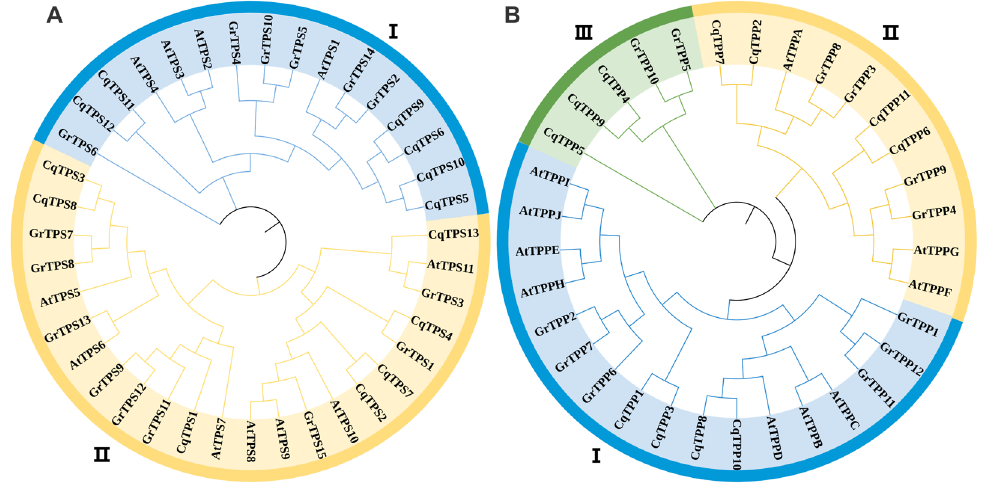
Figure 1. Phylogenetic analysis of TPS and TPP gene familes of Chenopodium quinoa Willd, Arabidopsis thaliana (L.), and Gossypium hirsutum Linn . ( A ) A phylogenetic tree containing 13 CqTPSs , 11 AtTPSs , and 15 GrTPSs , which are divided into two Classes distinguished in different colors. ( B ) A phylogenetic tree containing 11 CqTPPs , 10 AtTPPs , and 12 GrTPPs , which are divided into three Classes distinguished in different colors. I, II and III represent Class I, Class II and Class III respectively.